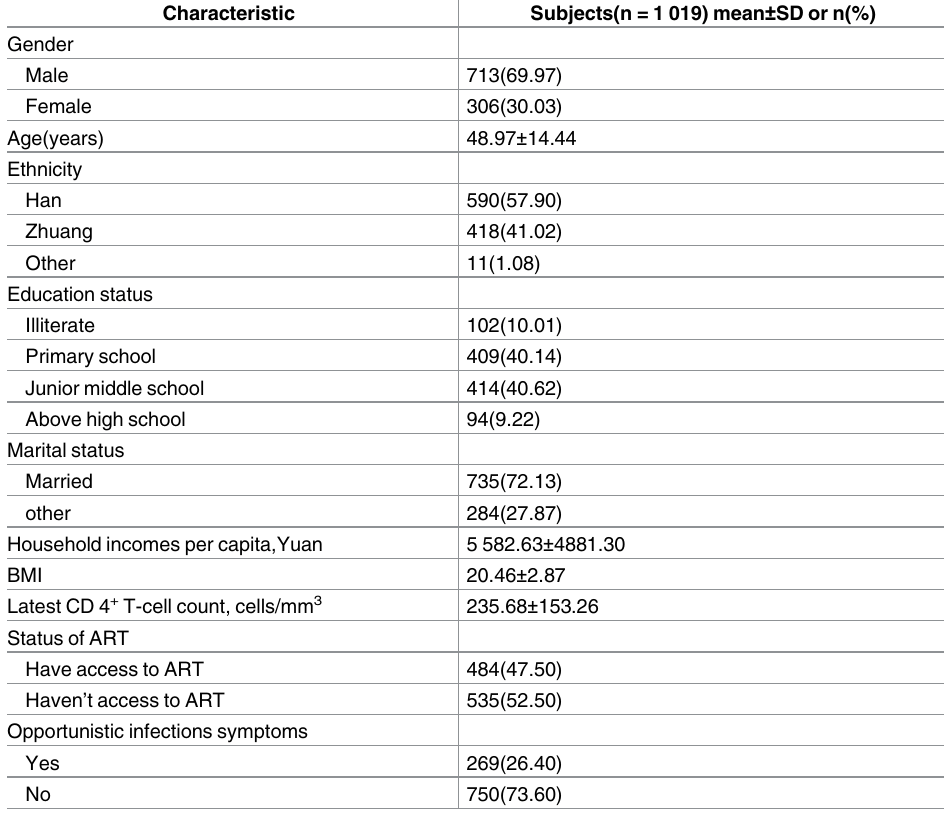
Table 1. HIV/AIDS cohort